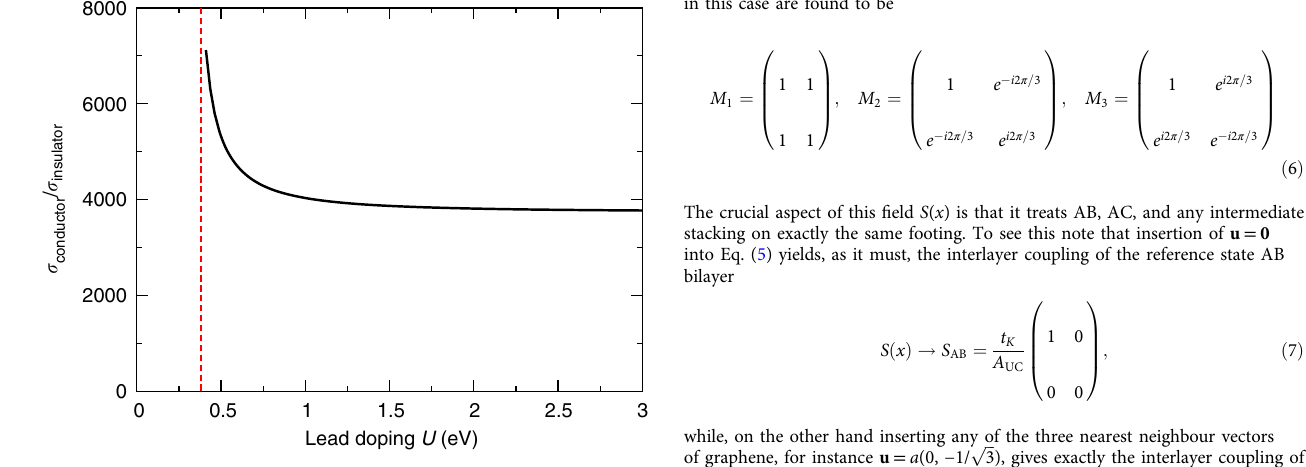
Fig. 7 Dependence of two-state transport on lead doping. Shown are the ratio of the conductivities of the insulating and conducting systems exhibited in Fig. 4 a , b as a function of the lead doping U . Evidently the dramatically different transport states of the two bilayer samples are